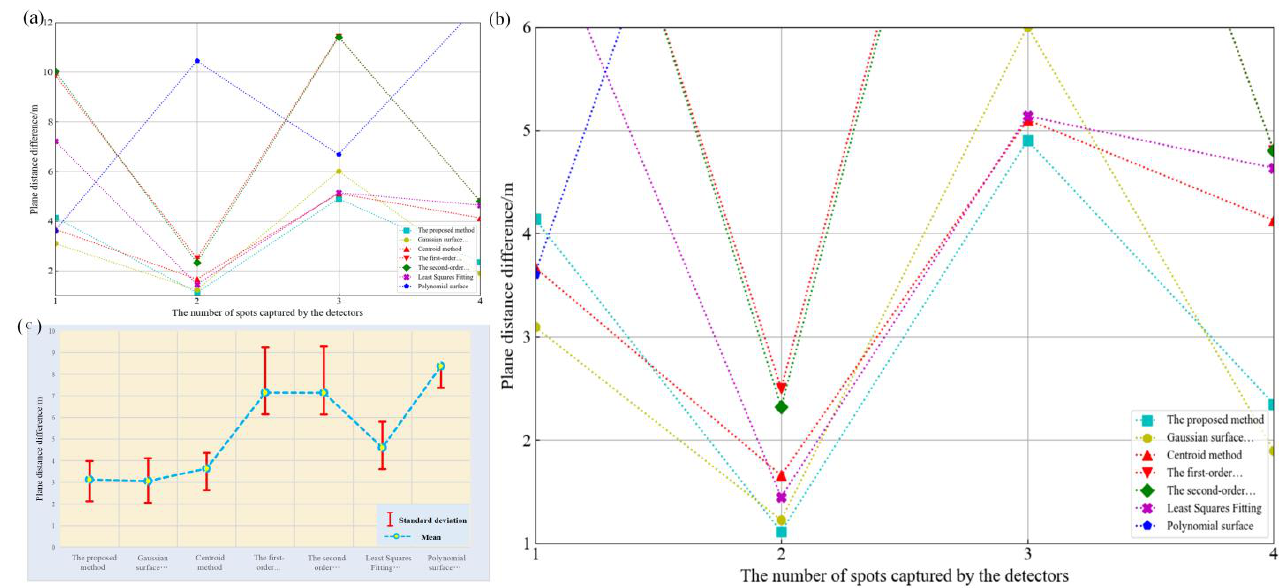
Figure 12. ( a ) Plane difference between laser footprint positioning results and centroid extraction results obtained with calibration parameters obtained using different methods; ( b ) partial enlarged drawing of ( a ); ( c ) Mean and standard deviation of results obtained using different methods.